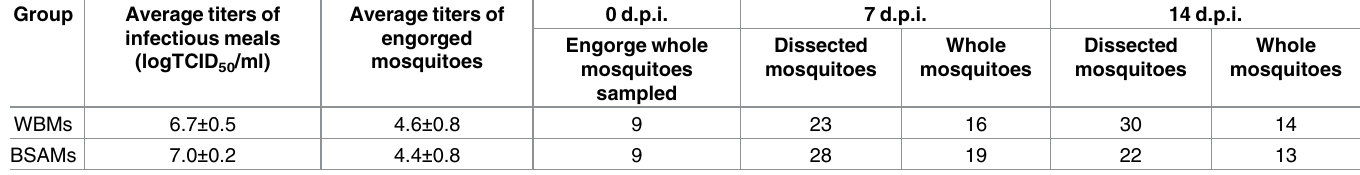
Table 1. Averagetiters of ZIKV infectious meals and engorged mosquitoes and the numbers of mosquitoes sampled at 7 and 14 d.p.i. Group Average titers of Average titers of infectious meals engorged (logTCID 50 /ml) WBMs 6.7 ±